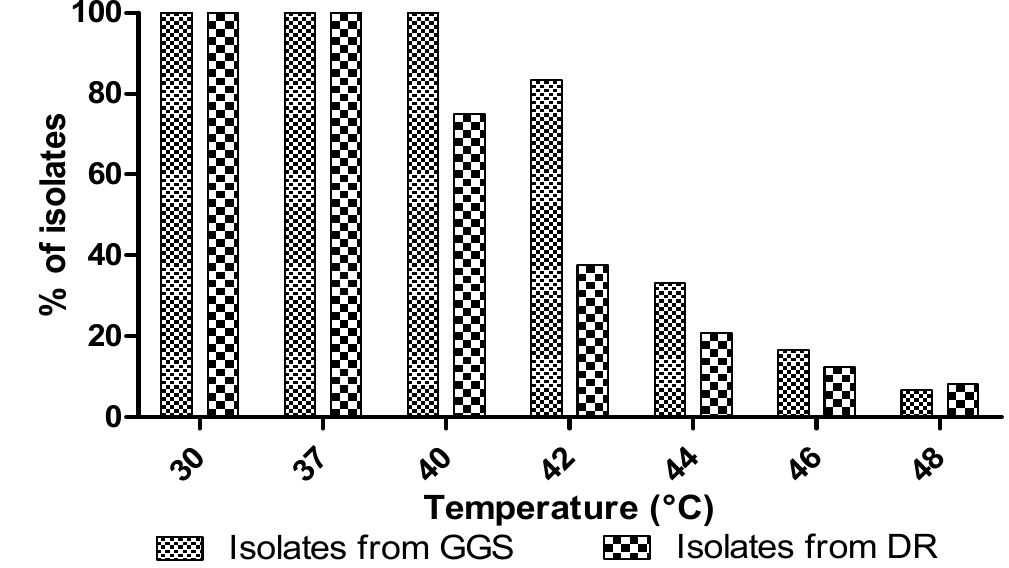
Figure 3. Effect of temperature on the growth of yeast isolates.